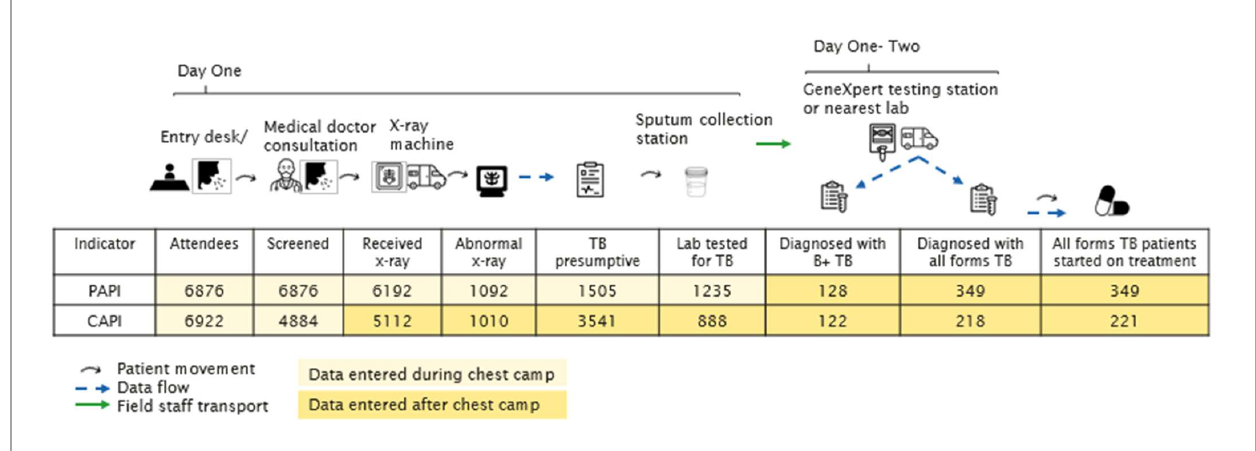
Figure 2. Chest camp intervention logic and flow of participants and data.